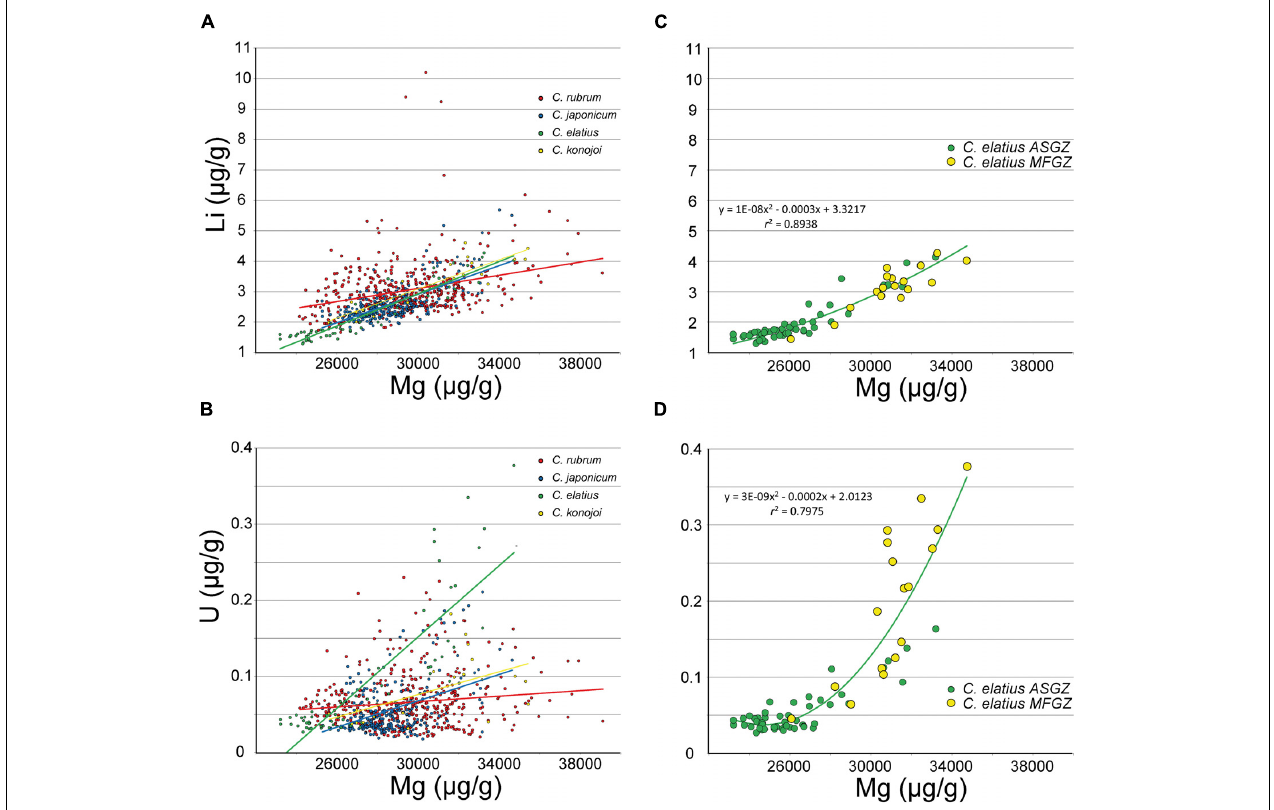
FIGURE 5 | LA-ICPMS data. (A,B) Li and U vs. Mg in C. rubrum, C. japonicum, C. elatius and C. konojoi (equations and correlation coefficients in Supplementary Material – SM1 Table 3 ). (C,D) C. elatius data extracted from (A,B) (equations and correlation coefficients from MFGZ and ASGZ combined